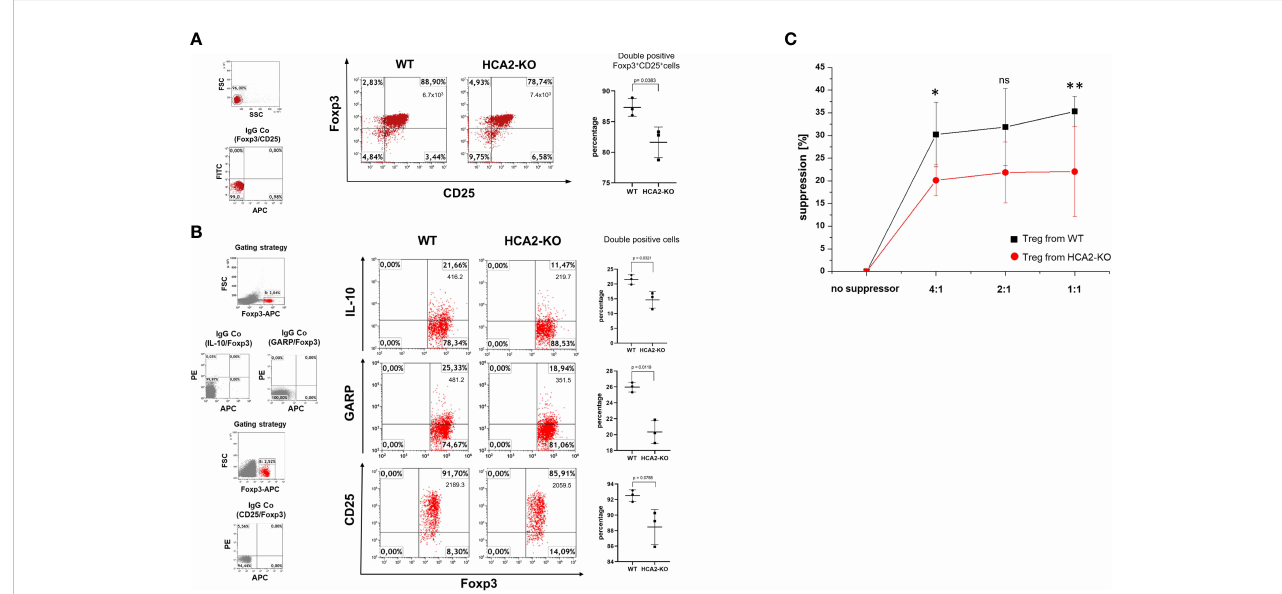
FIGURE 2 HCA2 signaling regulates the suppressive activity in vitro and the phenotype of Treg. (A) CD4 + CD25 + (Treg) cells were isolated from pooled spleens and lymph nodes (LN) of 7 mice and subjected to FACS analysis. The cell population from both strains was analyzed for double positive CD25/Foxp3 cells and is demonstrated as percentage and total number of double positive cells. As negative control served isotype (IgG Co). FACS analysis is also shown as a scatter graph with mean ± SD. Y axes show percentage of double positive cells. Data were analyzed by using the t test with Welch´s correction. n = 3 (B) Pooled LN cells and splenocytes of 4 mice, obtained from both strains were analyzed for double positive Foxp3/IL-10, Foxp3/GARP and Foxp3/CD25 cells and is demonstrated as percentage and total number of double positive cells. FACS analysis is also shown as a scatter graph with mean ± SD. Y axes show percentage of double positive cells. Data were analyzed by using the t test with Welch´s correction. n = 3 Data are presented from one of three independent experiments. (C) Pooled LN and spleen cells obtained from WT and HCA2-KO mice (4 for each group) were separated into CD4 + CD25 - (responder cells) and CD4 + CD25 + cells (Treg). Treg and responder cells were mixed at the ratios 1:1, 1:2 and 1:4. Responder cells were activated and after 4 days, cell proliferation was measured using Cell Counting Kit-8. Data are presented as percent suppression from one of three independent experiments. Student t test and one-way ANOVA was performed. *P < 0.03 WT vs HCA2-KO 4:1; P = 0.11504 WT vs HCA2-KO 2:1; ns, not signi fi cant; **P < 0.04 WT vs HCA2-KO 1:1; P ANOVA = 0.016; n =